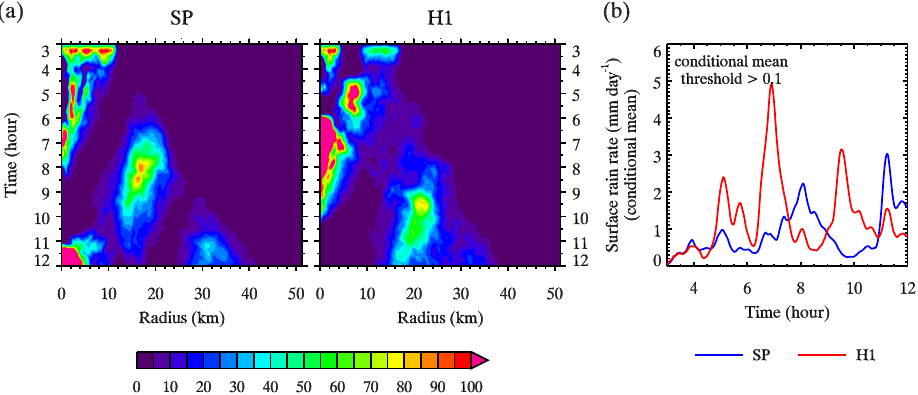
Figure 10. (a) Hovmöller diagram of the radially averaged RWP (gm − 2 ) for SP and H1. (b) Conditional mean surface rain rate for SP and H1 (grid points with rain rate > 0 . 1mmday − 1 averaged over the domain). A 15min running mean is